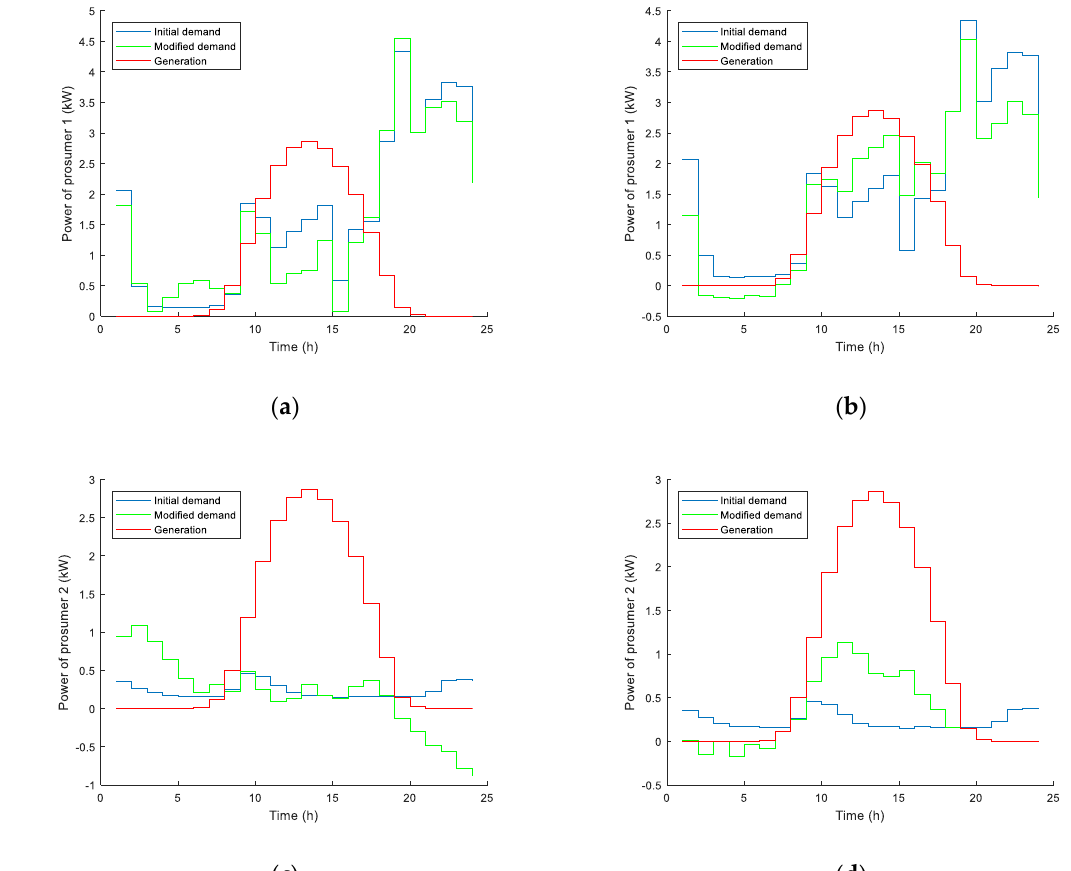
Figure 4. Generation, demand and modified demand hourly power curves during scheduled 24 h: ( a ) Prosumer 1, COF; ( b ) Prosumer 1, MOF; ( c ) Prosumer 2, COF; ( d ) Prosumer 2, MOF.